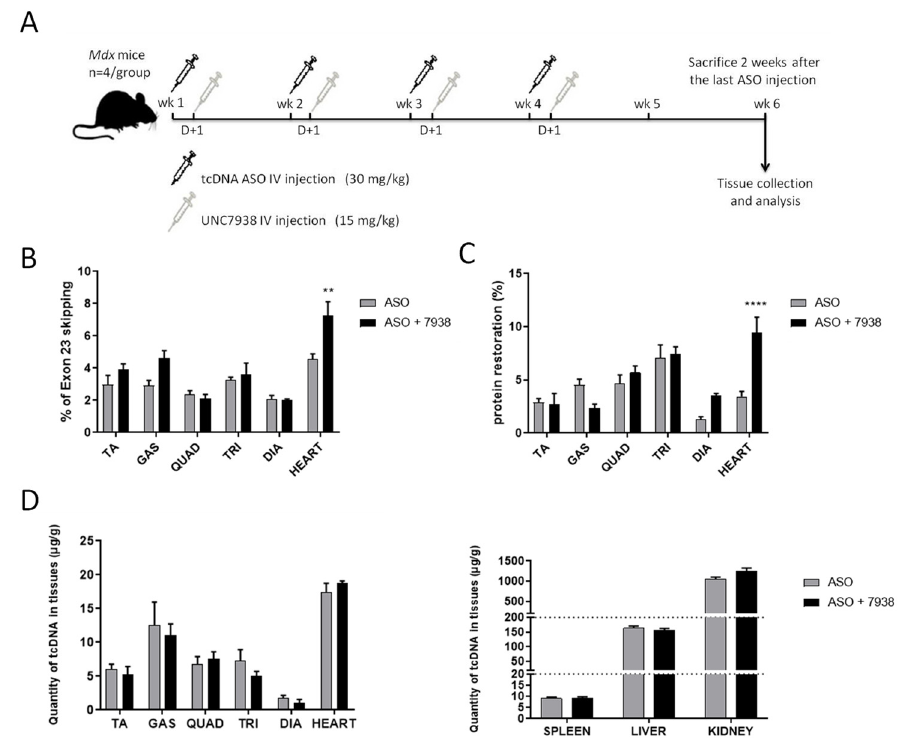
Figure 1. Short term efficacy of UNC7938 on exon skipping therapy in mdx mice. ( A ) Schematic representation of the injection protocol with tcDNA-ASO and the OEC UNC7938 in mdx mice. ( B ) Effect of UNC7938 on exon 23 skipping level. qPCR quantification of exon 23 skipping using taqman qPCR in the different muscle tissues. Tibialis anterior (TA), gastrocnemius (GAS), quadriceps (QUAD), triceps (TRI), diaphragm (DIA), and heart. n = 4 mice per group, ** p < 0.01 compared to ASO analyzed by RM two-way ANOVA. ( C ) Dystrophin restoration in treated mdx mice assessed by Western blotting. n = 4 mice per group, **** p < 0.0001 compared to ASO analyzed by RM two-way ANOVA. ( D ) Quantification of ASO in the different muscles tissues (left panel) and accumulation organs, such as spleen, liver, and kidney (right panel) after four weeks of treatment. Results are expressed as mean ± SEM; n = 4 mice per group.